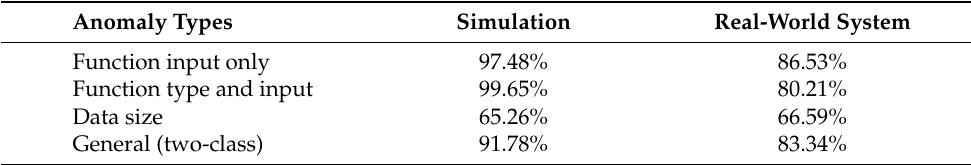
Table 4. Accuracy of rule-based anomaly